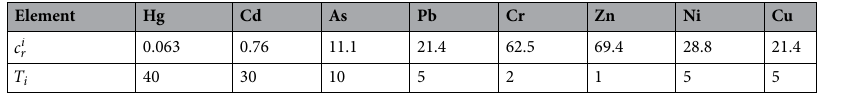
Table 3. Environmental background values and toxic-response parameters of heavy metals in the soil.